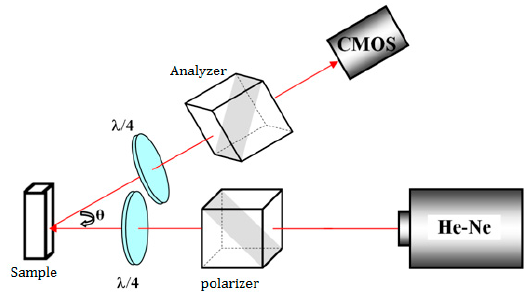
λ /4 is a quarter-wave